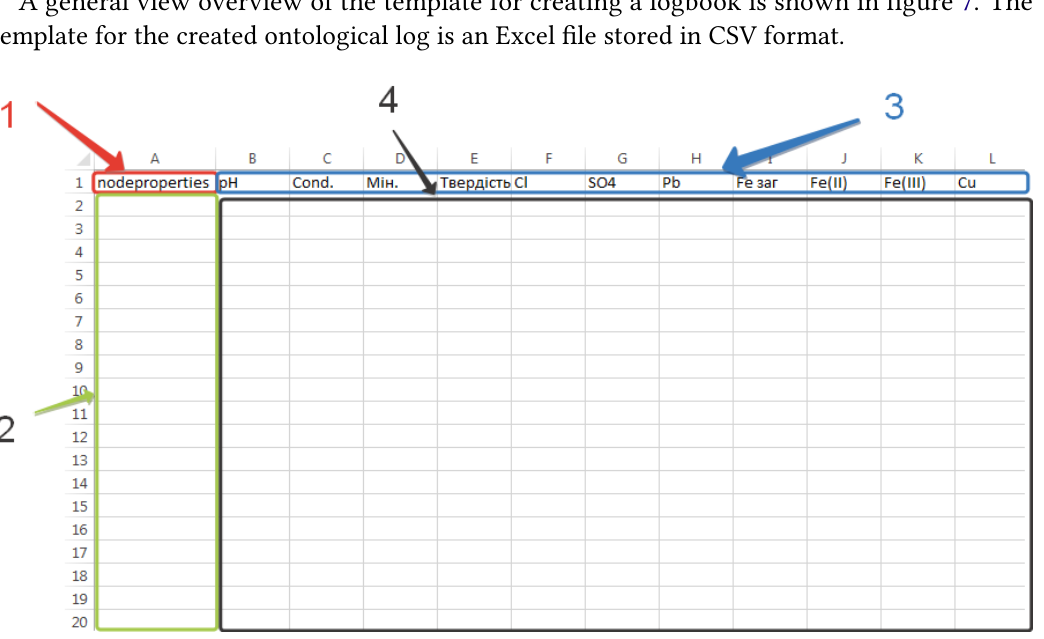
Figure 7: General view of the template for creating an ontological